Question: Is the quantity shown trending increasing or decreasing?
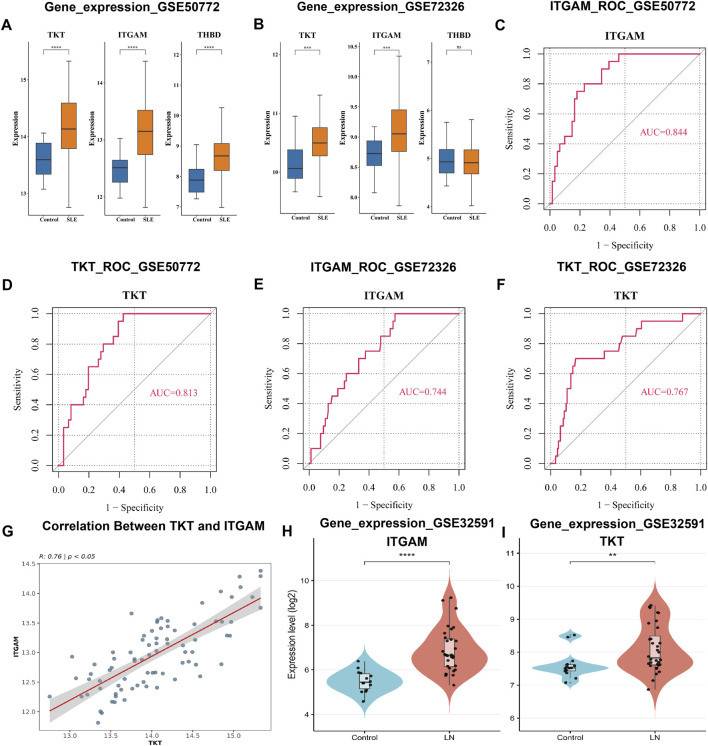
Answer: increasing